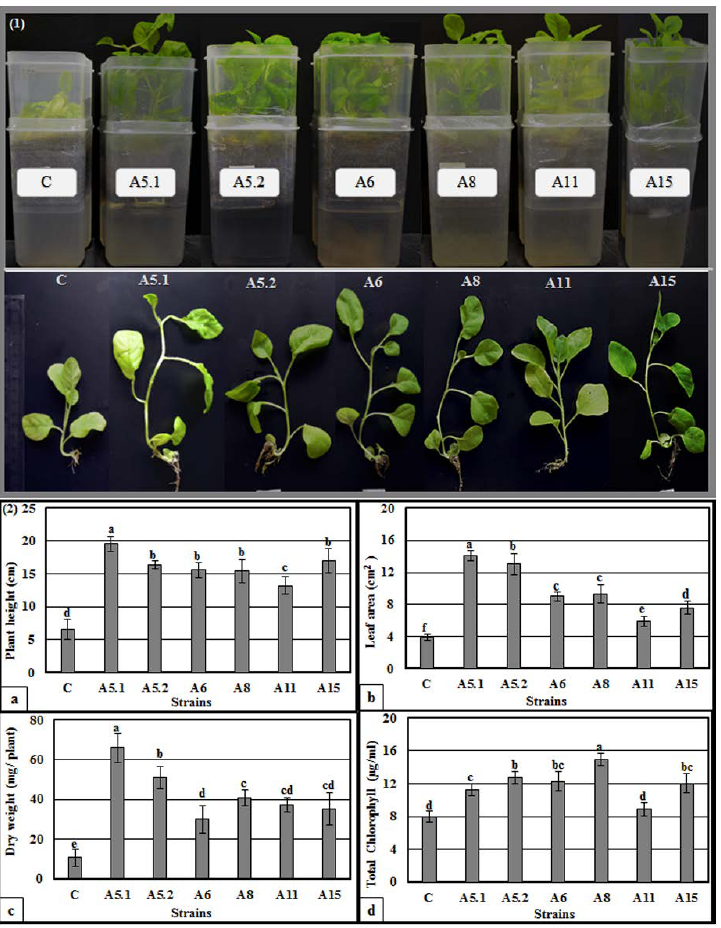
Figure 4. Direct effects of isolated fungi on promoting tobacco seedling growth in liquid MS medium. ( 1 ): Morphology of tobacco seedlings directly affected with six isolated fungi. For treated plants, MS medium was inoculated with five microliters of the isolated fungi two weeks after sowing. ( 2 ): Direct effects of isolated fungi on plant height ( a ), leaf area ( b ), plant dry weight ( c ), and total chlorophyll ( d ). Data are the means of five replicates ± standard deviation; different letters on bars represent the significant values according to Duncan’s test ( p < 0.05). (A5.1: Byssochlamys spectabilis , A5.2: Chaetomium globosum , A6: Cephalotheca foveolata , A8: Penicillium melinii , A11: Alternaria tenuissima and A15: Nigrospora chinensis